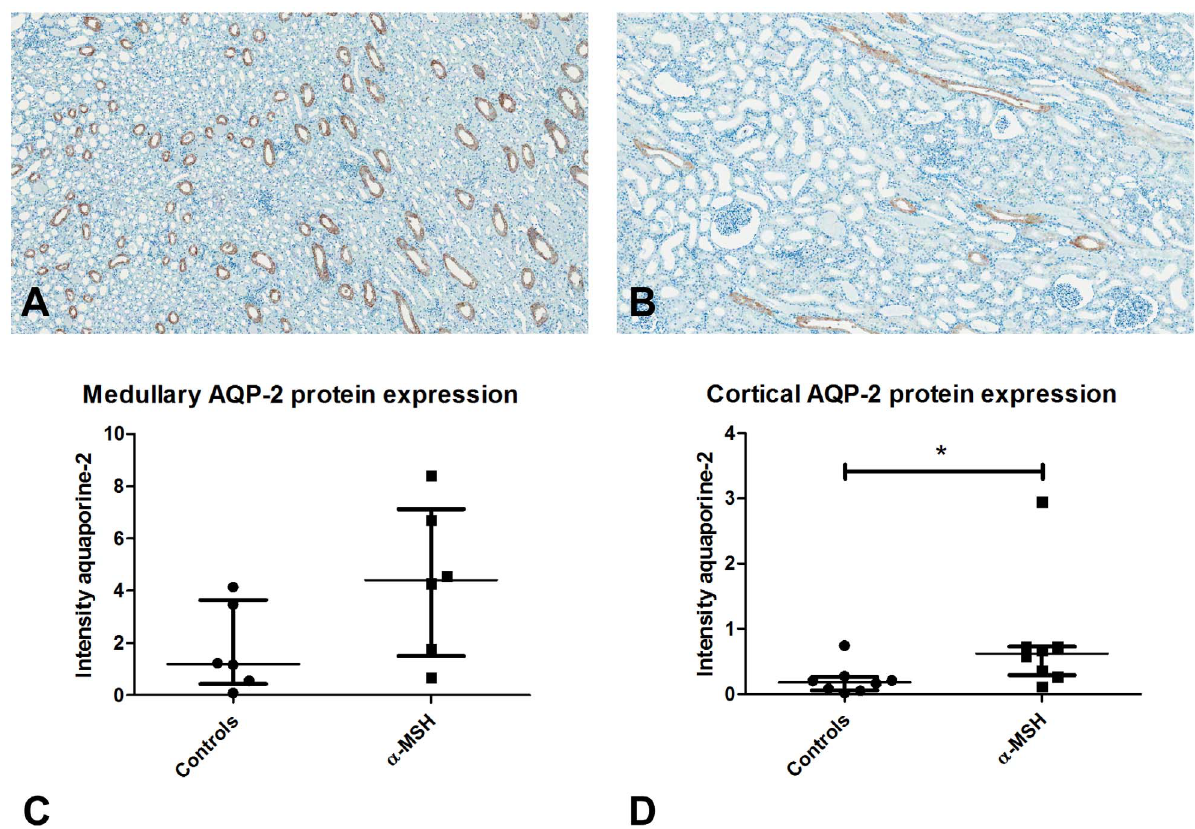
Figure 11. The effect of a -MSH on AQP-2 protein expression. Figure 11A and 11B show sections of medullary and cortical AQP-2 staining, respectively. No differences were observed in medullary AQP-2 expression (C), while a -MSH significantly increased cortical protein expression of AQP- 2 (D; *=p , 0.05). Figure S3 Effect of a -MSH on plasma ASAT and ALAT levels.